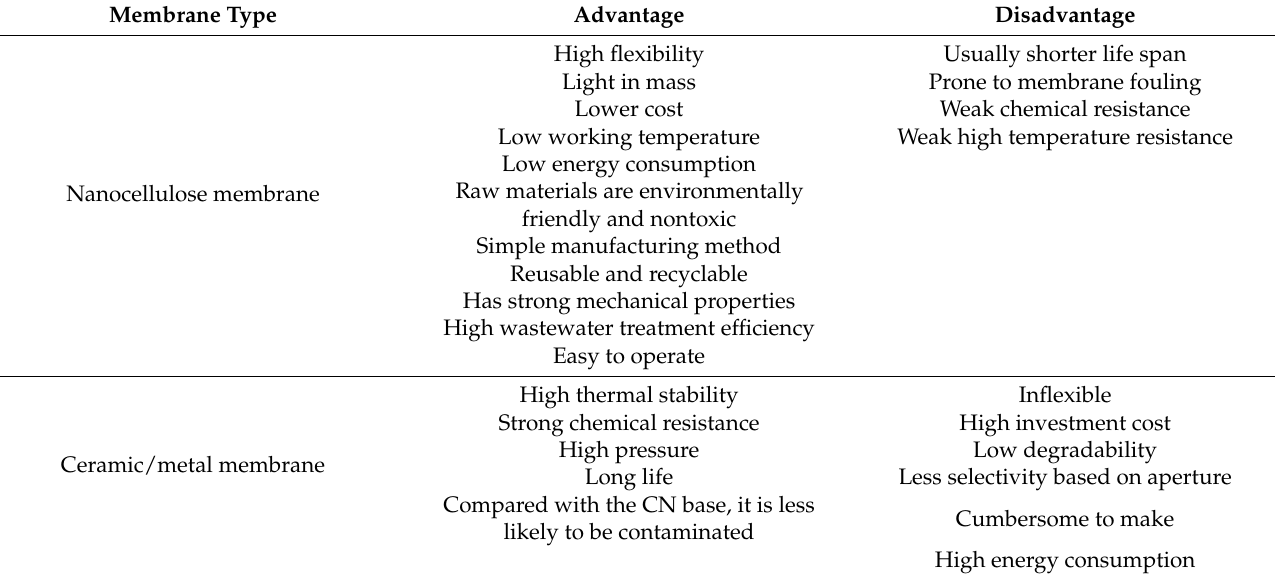
Table 3. Comparison of the advantages and disadvantages of nanocellulose membranes and ceramic membranes. Membrane Type Advantage Disadvantage High flexibility Usually shorter life span Light in mass Prone to membrane fouling Lower cost Weak chemical resistance Low working temperature Weak high temperature resistance Low energy consumption Raw materials are environmentally Nanocellulose membrane friendly and nontoxic Simple manufacturing method Reusable and recyclable Has strong mechanical properties High wastewater treatment efficiency Easy to operate High thermal stability Inflexible Strong chemical resistance High investment cost High pressure Low degradability Ceramic/metal membrane Long life Less selectivity based on aperture Compared with the CN base, it is less Cumbersome to make likely to be contaminated High energy